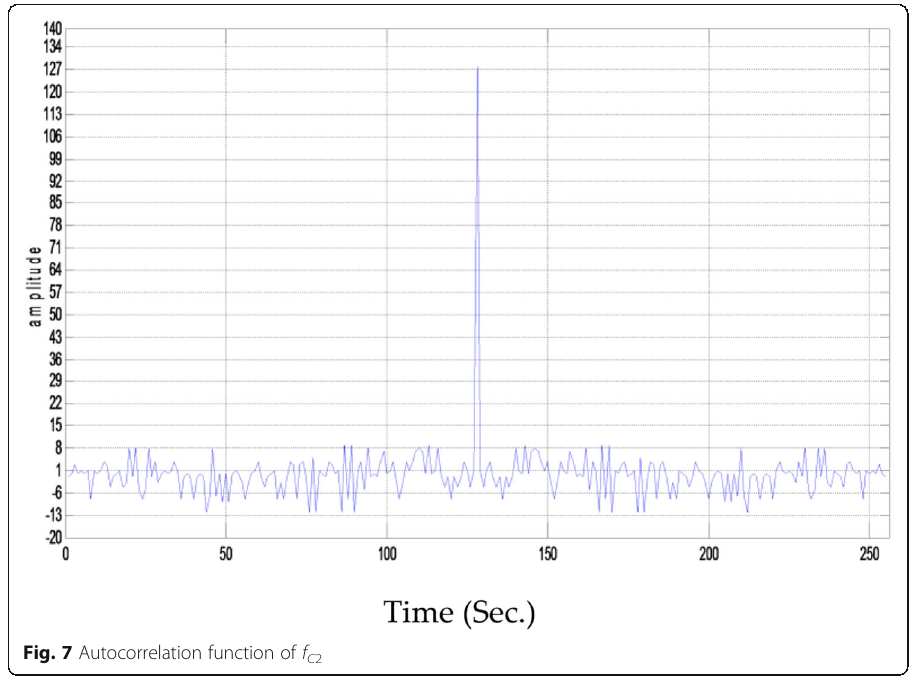
Fig. 7 Autocorrelation function of f C 2